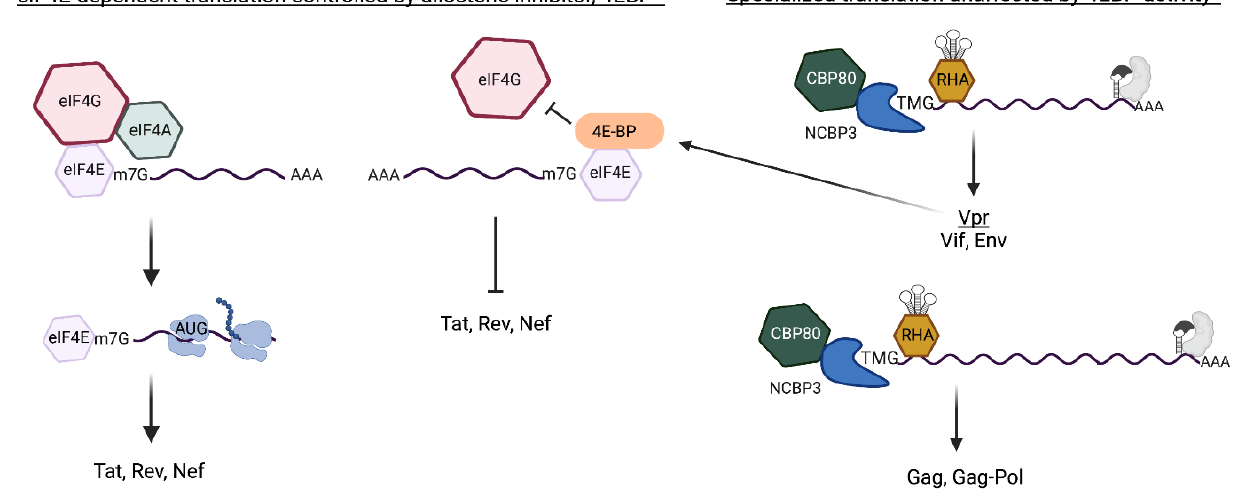
Figure 6. The HIV early and late mRNAs engage independent translation pathways that interdependently control the expression of viral regulatory proteins and structural/accessory proteins. ( Left ) HIV early mRNAs are fully processed mRNAs that undergo canonical eIF4E-dependent translation to Tat, Rev and Nef. Hypo-phosphorylated (hypo) 4E-BP allosterically binds eIF4E and blocks eIF4G interaction and halts the translation initiation. ( Right ) Trimethylguanosine (TMG)-cap of the Rev/Rev-responsive element (RRE)-dependent mRNAs licenses specialized translation independently of eIF4E activity. HIV unspliced and singly spliced (US and SS) mRNAs engage Rev at the RRE (gray protein binding gray RNA element) and subvert canonical CBC exchange to eIF4E and engages CBP80/NCBP3 Vpr upregulates hypo-4E-BP [75] and inhibits eIF4E-dependent translation of host proteins and Tat, Rev, Nef. The specialized translation of the Rev/RRE-dependent TMG-capped mRNAs endures until lack of Tat/Rev activity curtails biosynthesis of the US/SS RNA [20]. The downregulation of the TMG-capped mRNAs encoding viral accessory/structural protein and attenuates virus proliferation [20].